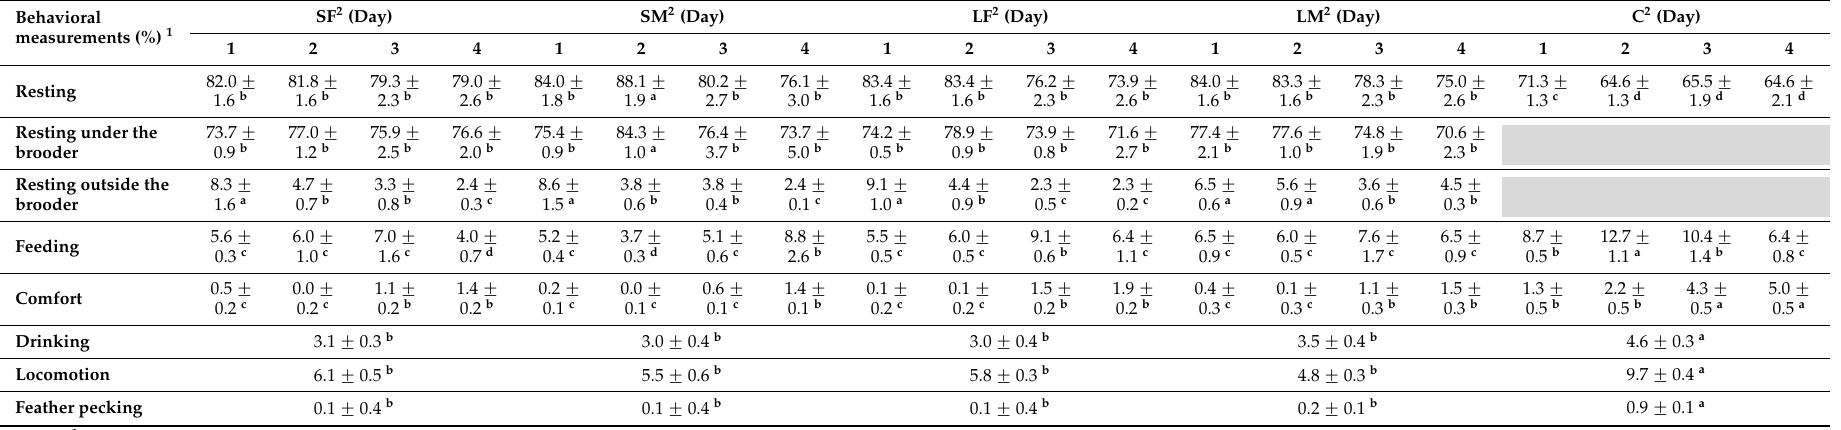
Table 1. Proportion of layer chicks (%) performing various behavioral categories when 1, 2, 3, and 4 days old. Gray shaded areas indicate no available brooders. Behavioral measurements (%)